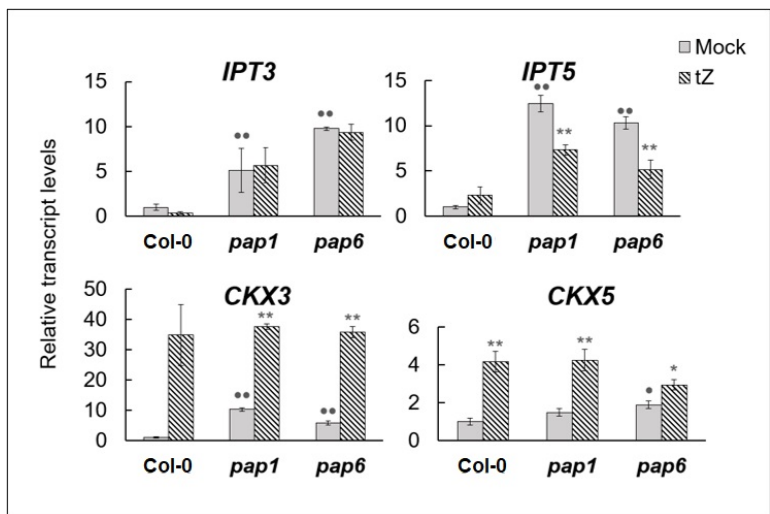
Figure 5. Relative expression values of A. thaliana IPT and CKX genes in untreated 4-week-old Col-0 plants and pap mutants, and under CK ( trans -zeatin 5 µM, 3 h) treatment. A. thaliana Col-0 and mutant plants were grown on MS medium in Petri dishes for four weeks under a 16 h light/8 h dark photoperiod at 23 °C with 100 µE m − 2 s − 1 . Total RNAs were isolated from rosette leaves and analyzed by relative quantitative RT-PCR using UBQ10 and PP2A as internal standards. Asterisks and points indicate significant di ff erences from the Col-0 and respective mock controls (* and • p < 0.05; ** and •• p <